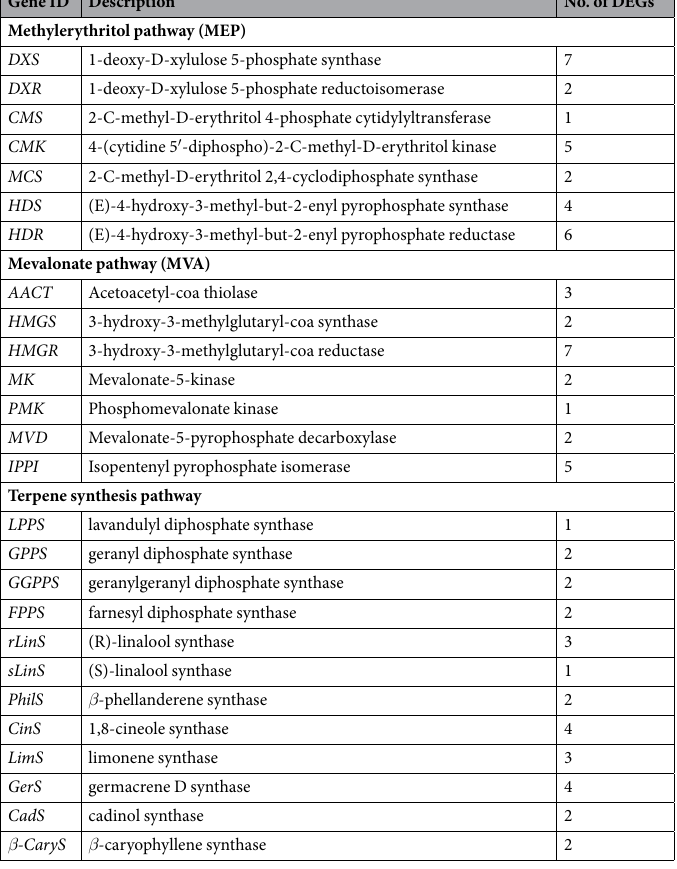
Table 1. Summary of annotations of unigenes associated with essential oil-synthesis pathways in L . angustifolia transcriptome data.